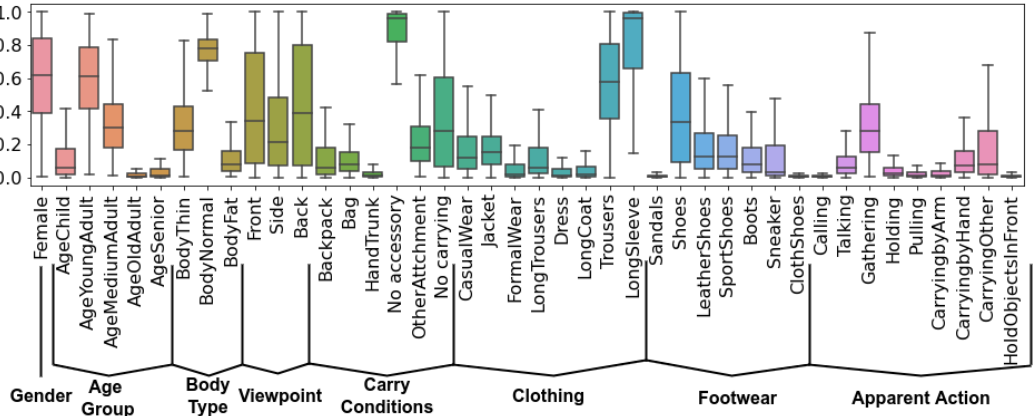
Figure 3. Distribution of the 42 appearance attributes in DenseGait. The dataset is annotated in a fine-grained manner with attributes ranging from internal aspects of the person (Gender, Age Group, Body Type) to appearance only labels (Clothing, Footwear).